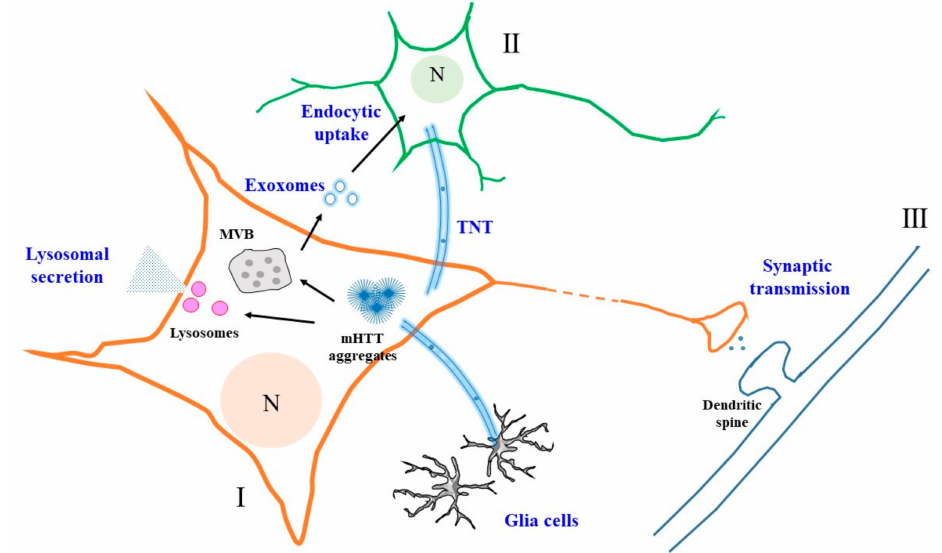
Figure 1. A schematic diagram illustrating the various modes of mutant Huntingtin (mHTT) unconventional secretion and intercellular propagation. Secretion from one neuron (I) could occur via exosomes when luminal vesicles from the multivesicular body (MVB) fuse with the plasma membrane. These exosomes could be taken up endocytically by another neuron (II). Secretion could also occur via a lysosome-based mechanism, with the release of non-vesicular mHTT. Interneuronal transfer, particularly between neurons (I and III) connected within a neural circuit, could occur via vesicles generated at the synaptic terminals. Intercellular transfer of mHTT aggregates could also occur via tunneling nanotubes (TNTs). N—nucleus. See text for more